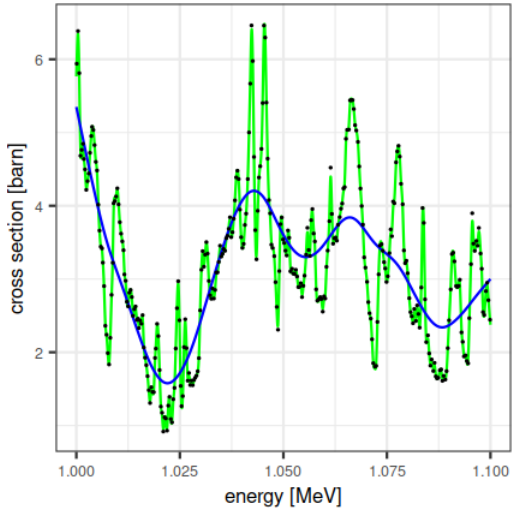
Figure 3. MAP estimate of the node ⃗σ resulting from two dif- ferent prior uncertainty specifications of α . The blue line is the result for α = 10 4 and the green line for α = 10 7